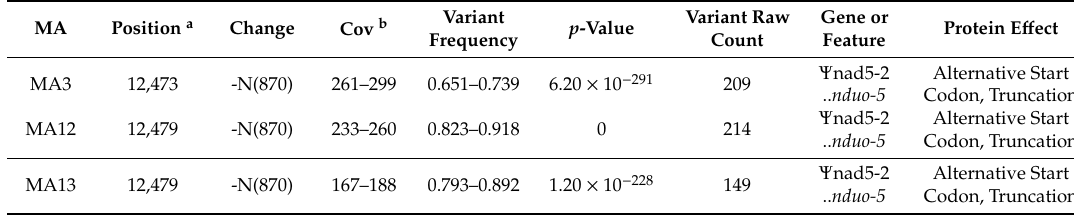
Table 3. Identified deletion events in AF16 MA